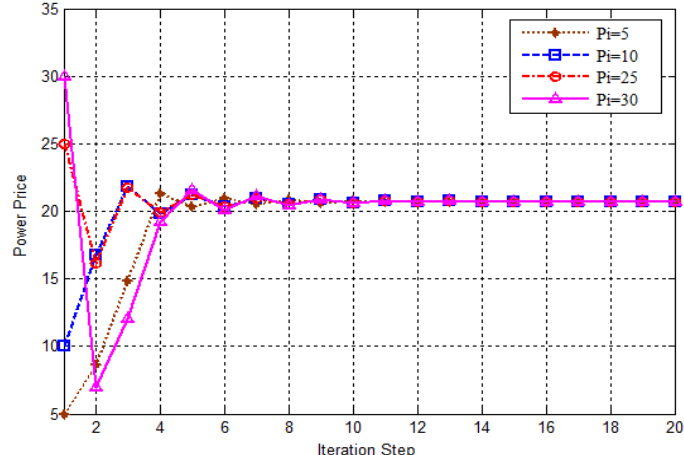
Figure 5. Power price offered by SGO i versus the iteration step, in which its initial price p i = 10 $/MW · h, η 1 = 0.95, η 2 = 0.99, and S 1 = 6, S 2 = 7, respectively.